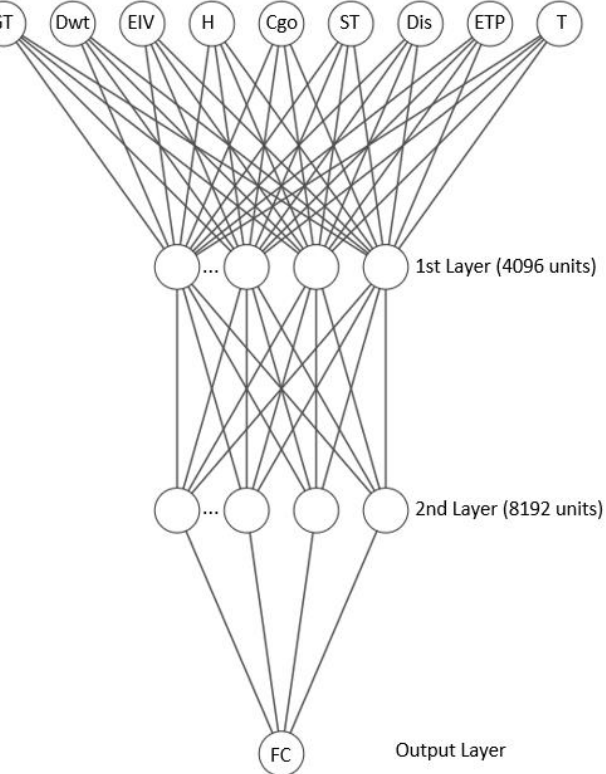
Figure 2. The network architecture of our DNN approach.